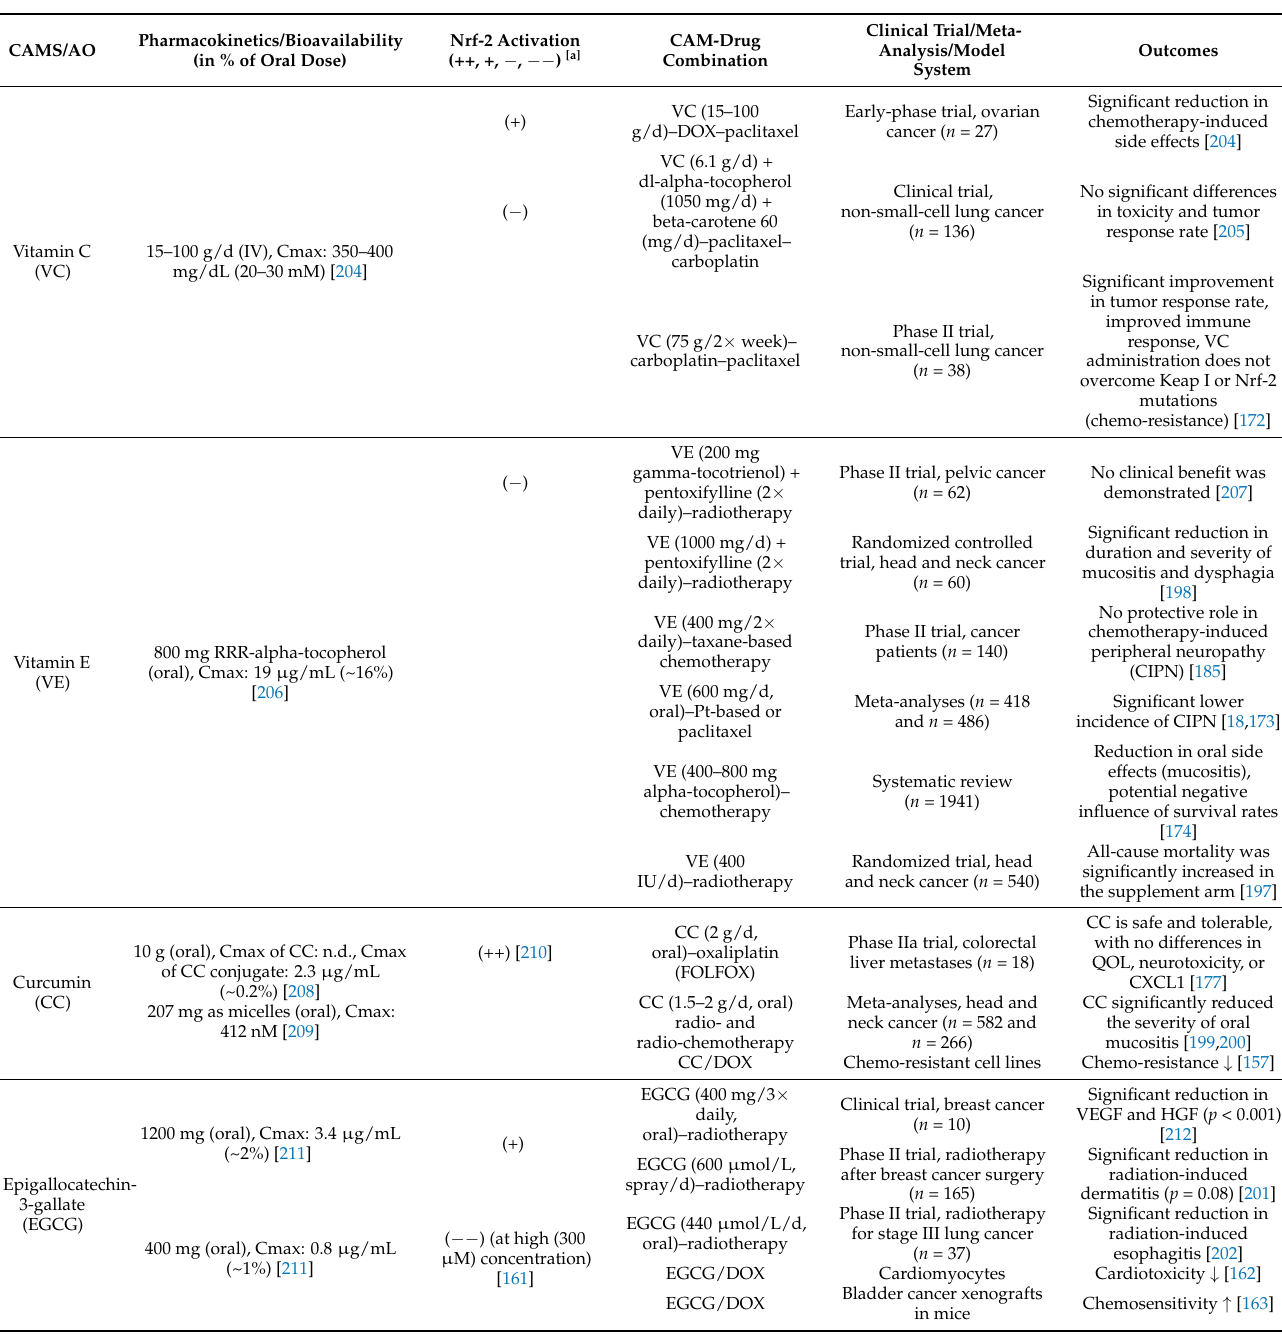
Table 2. Recent meta-analyses and trials (both pre-clinical and clinical) with vitamins C and E, melatonin, EGCG, curcumin, and sulforaphane, including additional data on pharmacokinetics and Nrf-2